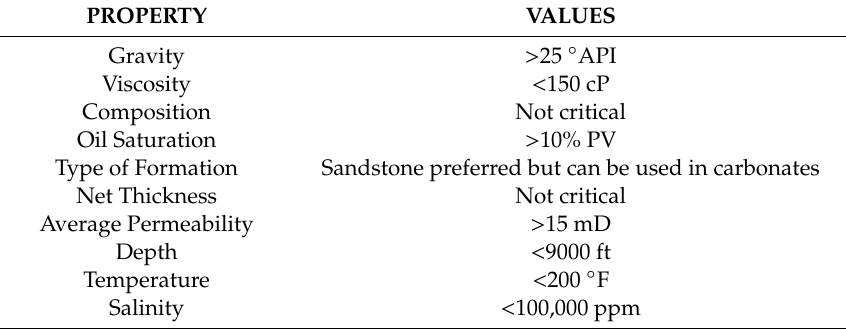
Table 2. Screening criteria for polymer